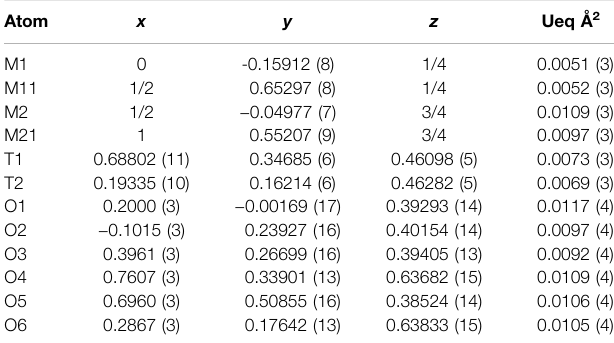
TABLE 3 | Atomic coordinates and equivalent isotropic displacement parameters of the non-hydrogen atoms in the omphacite